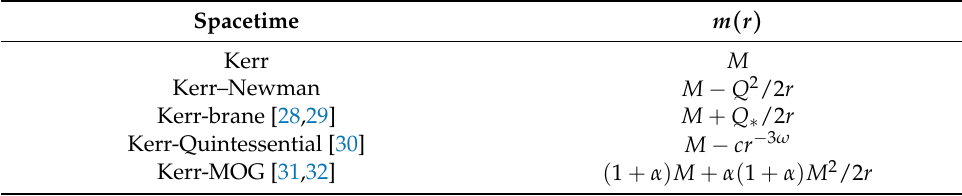
Figure 1. The schematic picture of the orbital and epicyclic motion of a particle around a black hole. The quantities ν r , ν θ , and ν φ represent the radial, vertical, and orbital frequencies of the test particle, respectively. Here, the definitions of ν i are given as ν i = Ω i /2 π with i = ( r , θ , φ ) . Table 1. The mass function for some of the rotating black